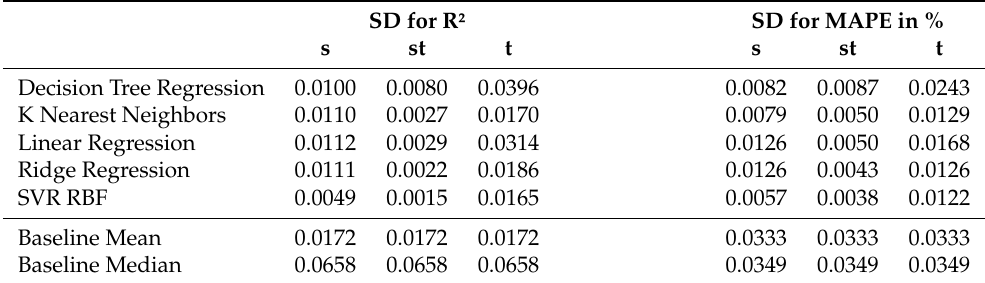
Table A4. Stacking Box Data Set I: standard deviations for the results of Target Distance B. SD for R² SD for MAPE in % s